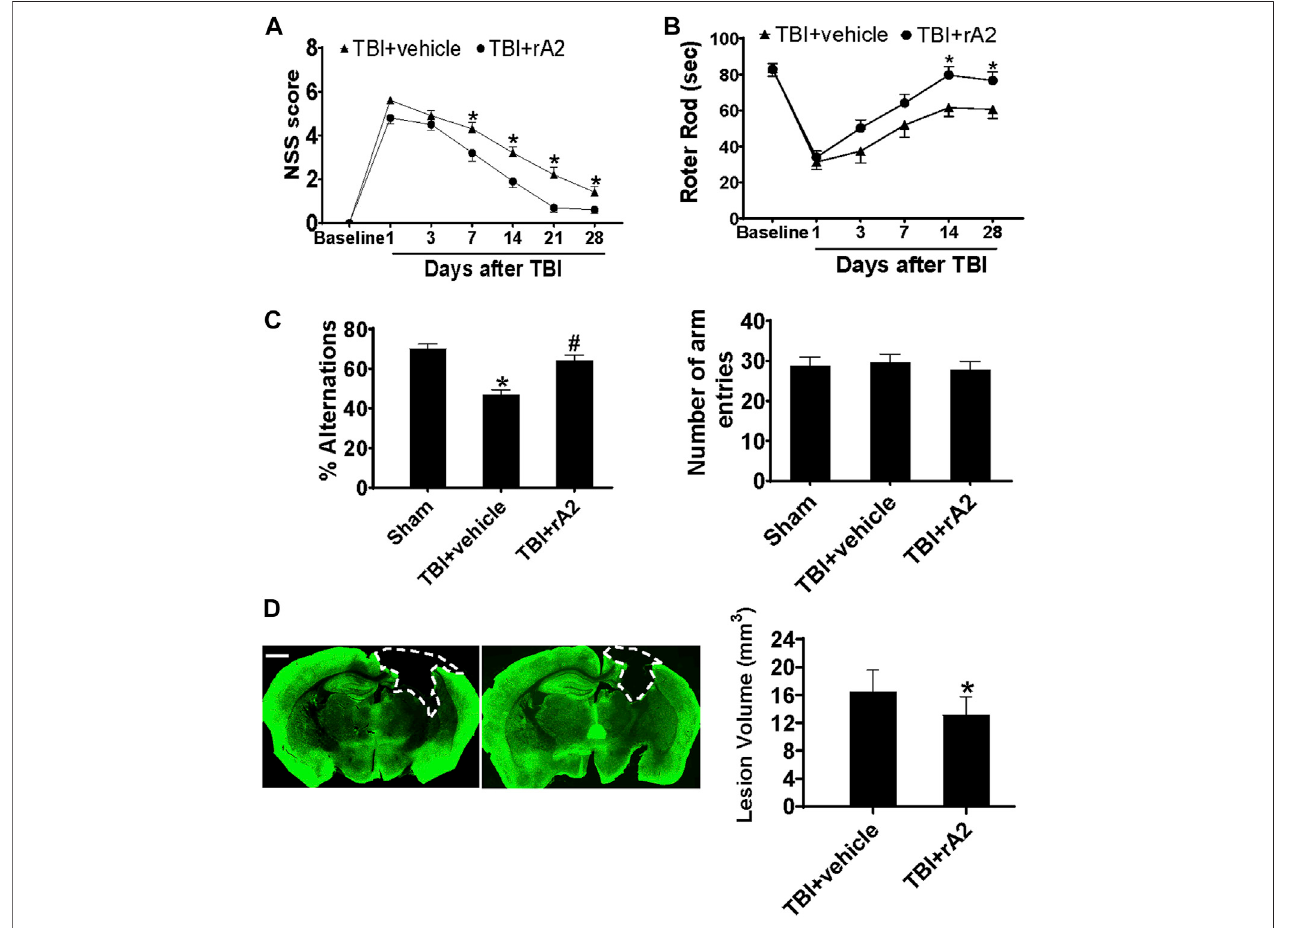
FIGURE5| rA2administration improvesneurologicaloutcomesandreducesbraintissueloss after TBIinmice. (A) .Modi fi edneurologicalseverityscore(NSS). (B) Rotor rod test. * p < 0.05 compared to TBI+vehicle (1 mg/kg BSA) at the same time point. (C) Y-maze test was performed at 21 days after TBI. n (cid:1) 14 mice per group. * p < 0.05comparedtoSham, # p < 0.05comparedtoTBI+vehicle(1 mg/kgBSA). (D) RepresentativeMAP2stainingandquanti fi cationoflesionvolume.Thedashedline indicates the border of the brain tissue loss. Scar bar, 1 mm * p < 0.05 compared to TBI+vehicle (1 mg/kg BSA). Data are expressed as mean ± SEM; n (cid:1) 14 mice per